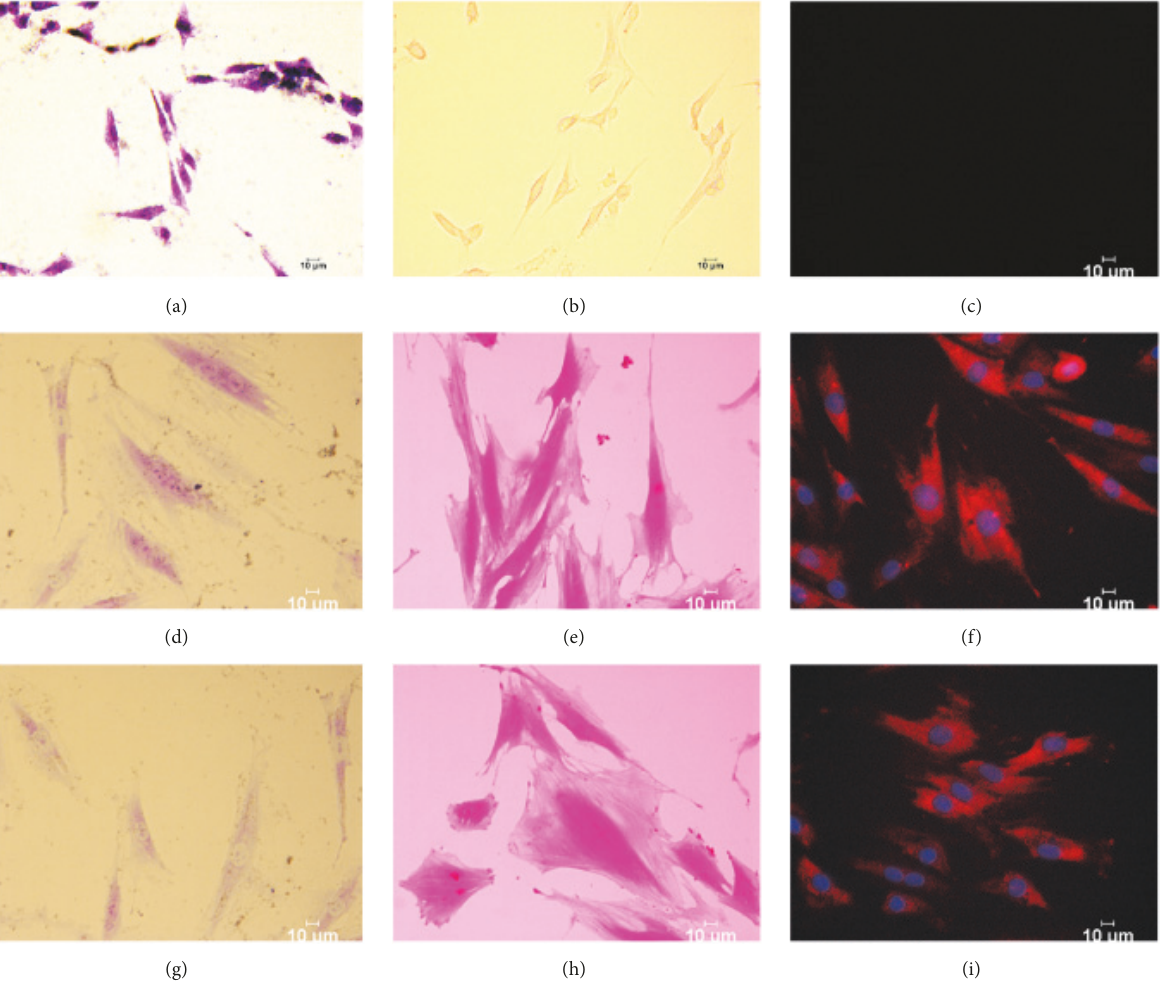
Figure6:StainingofMEFcells:(a-c)MEFcellstreatedwithpm-PPY;(d-f)Induced-MEFcells;(g-i):Chondrocytes.(a),(d),and(g)Toluidine blue staining. (b), (e), and (h) Safranine O staining. (c), (f), and (i) Immunofluorescence staining of collagen type